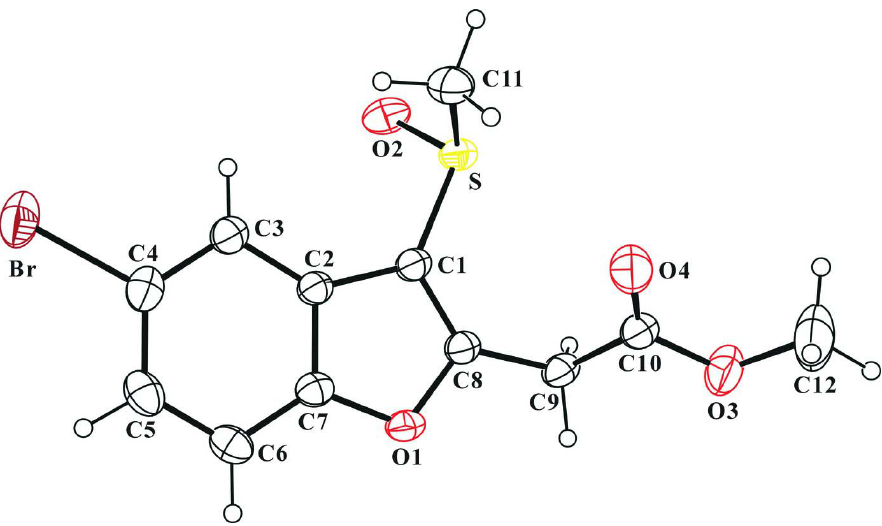
Figure 1 The molecular structure of compound (I), showing the atom numbering scheme and displacement ellipsoids drawn at the 30% probability level.